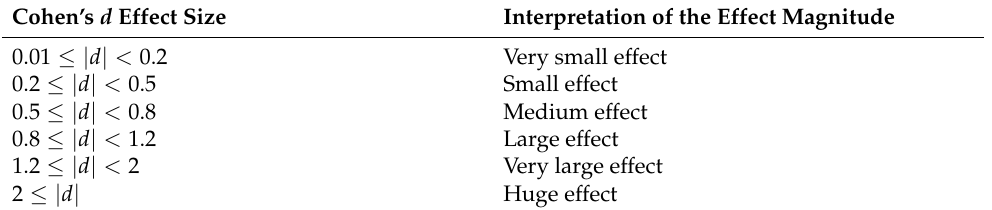
Figure 1. Boxplots of software metric values averaged per class. Table 7. Interpretation of Cohen’s d effect